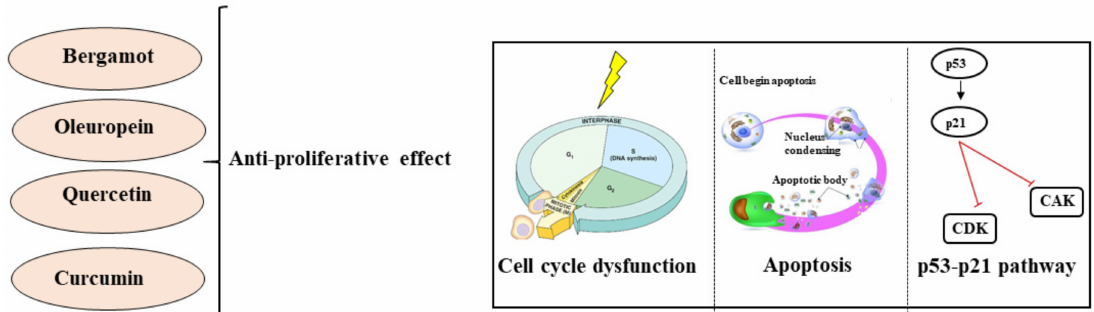
Figure 3. Anti-viability effects exerted by bergamot, oleuropein, quercetin, and